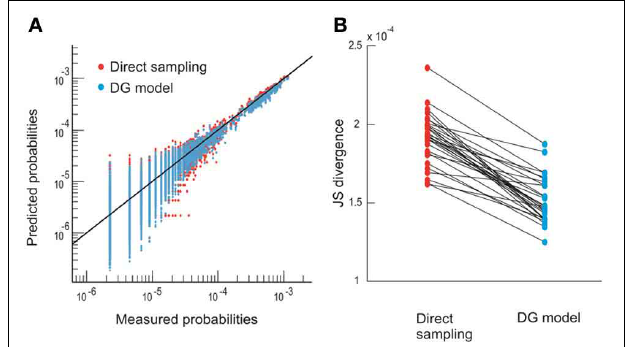
FIGURE 2 | The DG model predicts state probability more accurately than direct sampling. (A) Observed probability p i (thirty 10–electrode sub-groups) is plotted against the prediction made by direct sampling and the DG model. Solid line indicates equality. The comparison is based on 2-fold cross-validation (Yu et al., 2011). (B) JS divergence (Yu et al., 2011) between the observed and predicted probabilities of spatial avalanche patterns for the same thirty 10–electrode groups shown in (A) . Linked dots are the results obtained by direct sampling and the DG model for the same group. The DG model has significantly smaller JS divergence (21% reduction, p < 10 − 5 , paired-sample signed rank